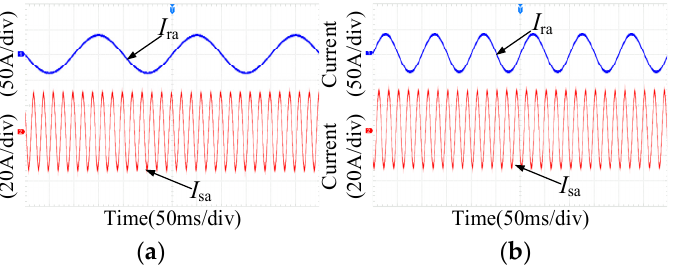
Figure 16. The DFIG determining the rotor current at different speeds: ( a ) rotor speed of 900 r/min; ( b ) rotor speed of 1200 r/min.